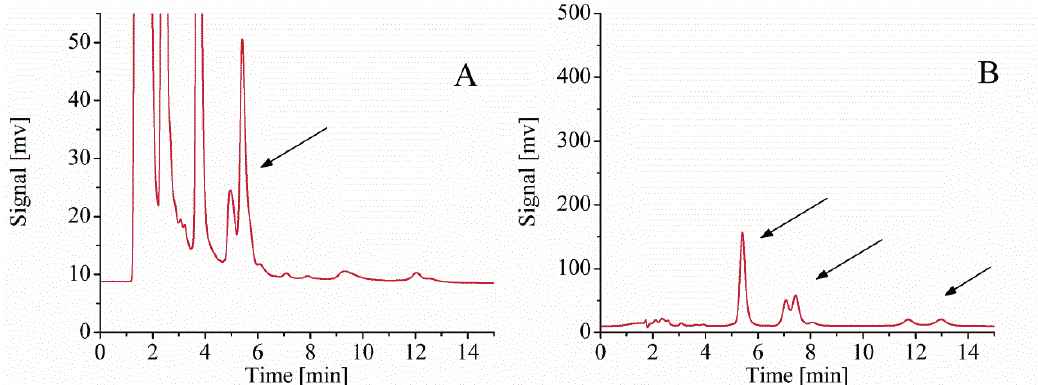
Figure 5. Inactivation of rapC gene by gene insertional mutation. ( A ) Construction of insertional mutation of the rapC gene; ( B ) Lane 1 : middle encoding region of rapC (595 bp) with the P1 and P2 as the primers ( C ) Verification of the single crossover mutants by PCR. Lane 1 – 4 : fragments (1069 bp) with the P3 and P4 as the primers; M: